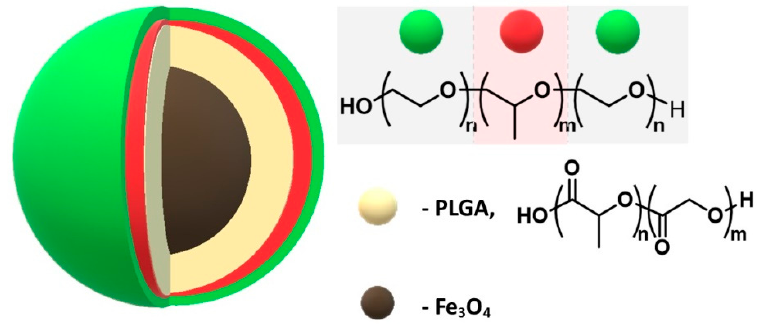
Figure 10. Scheme structure of poloxamer and adsorption of poloxamer onto MNPs-coated PLGA. 5.1.4. Immobilization of Proteins on Nanoparticles Coated with Polyethyleneimine (PEI)